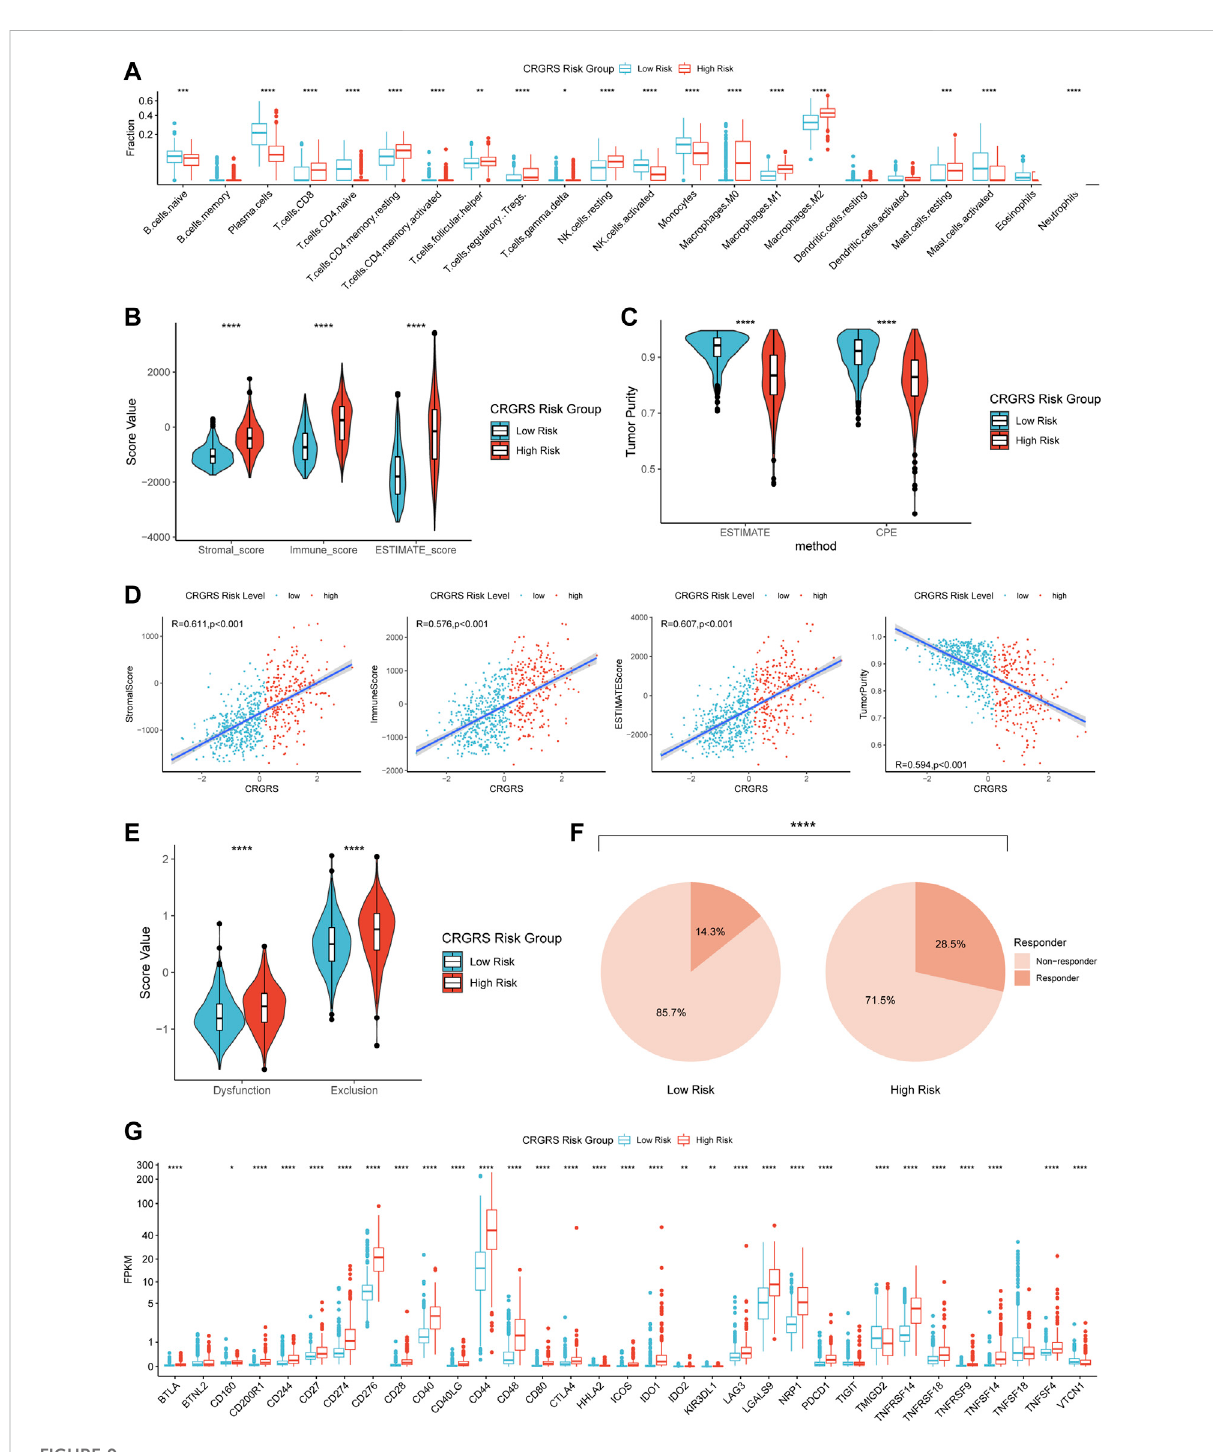
FIGURE 9 Differences in immune features of tumor microenvironment between two CRGRS risk groups. (A) Boxplot of the estimated fraction of 22 immune cells in tumors. (B) Stromal, immune, and ESTIMATE scores of the two risk groups. (C) Tumor purity of the two risk groups based on the ESTIMATE and CPE algorithms. (D) Analyses of correlations of CRGRS with the stromal, immune, ESTIMATE score, and tumor purity. (E) T cell dysfunction and exclusion score of two risk groups. (F) Percentage of predicted responders to immune checkpoint inhibitors therapy in each risk group. (G) The expression level of 33 immunotherapy-related genes in two risk groups. * p < 0.05; ** p < 0.01; *** p < 0.001; **** p <